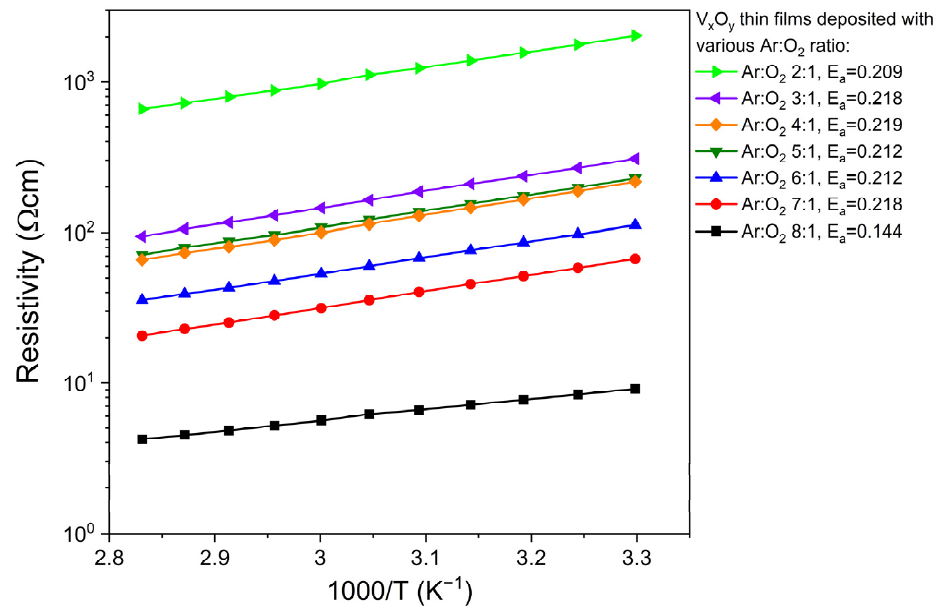
Figure 8. Resistivity as a function of 1000/T of vanadium oxide thin films deposited with various Ar:O 2 gas ratios during sputtering process.